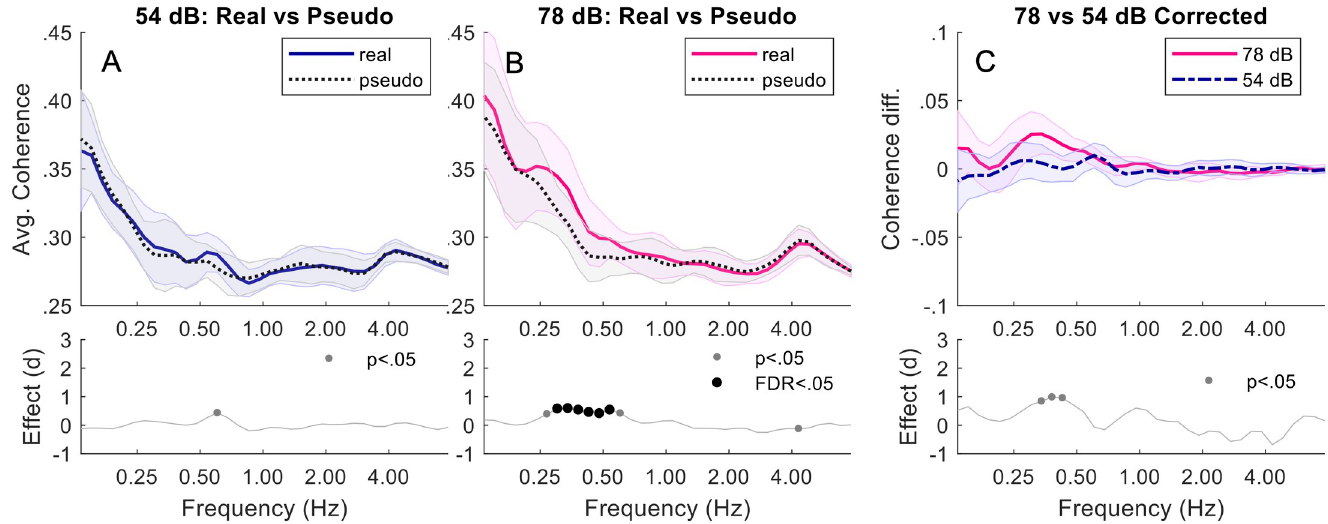
Fig 2. Dyads in speech-shaped noise. Top plots of (A) and (B) show the average wavelet coherence responses for Real vs Pseudo during 54 dB and 78 dB respectively. The mean coherence over all dyads (with standard error) is shown across a range of frequencies. The lower plots show the corresponding Pseudo-Real effect size (Cohen’s d), with both significance and FDR-adjusted significance (if any). (C) shows the corrected (baseline removed) coherence difference between 78 and 54 dB.